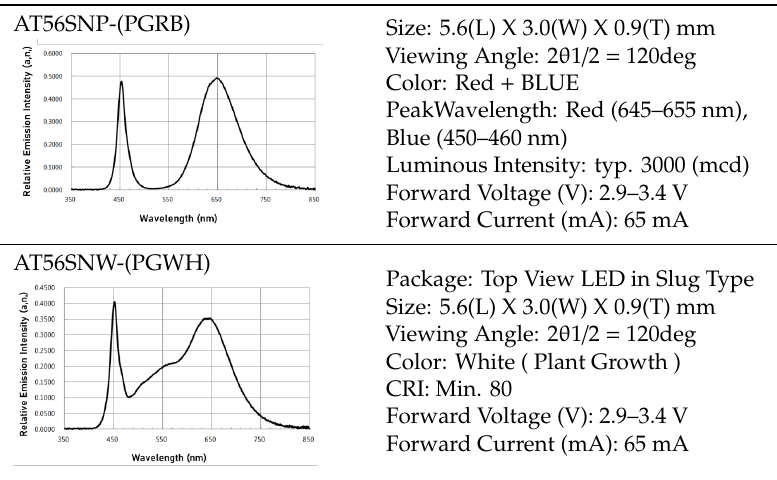
Figure 7 is a single circuit diagram with a variable resistor and 7 LEDs connected in series.